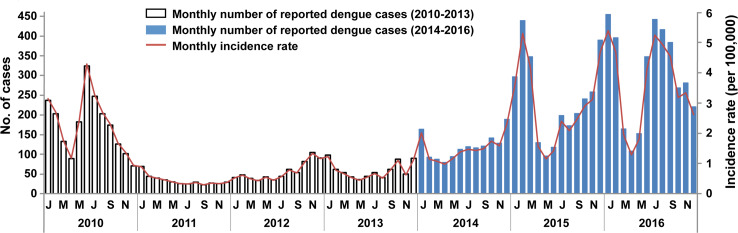
Temporal pattern of dengue in Sabah, 2010–2016.The monthly number of reported dengue cases per year are shown (primary vertical axis), and the corresponding monthly incidence rate (secondary vertical axis). Grey bars indicate the years 2010–2013 where case diagnoses were predominantly clinically-based (with or without laboratory confirmation), and blue bars indicate notifications following the 2014 change in case definition, where all cases were laboratory confirmed.